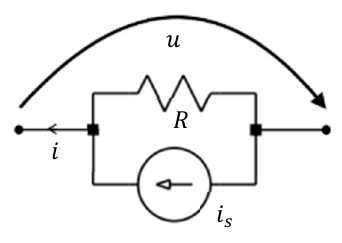
Figure 5. Equivalent real current source.